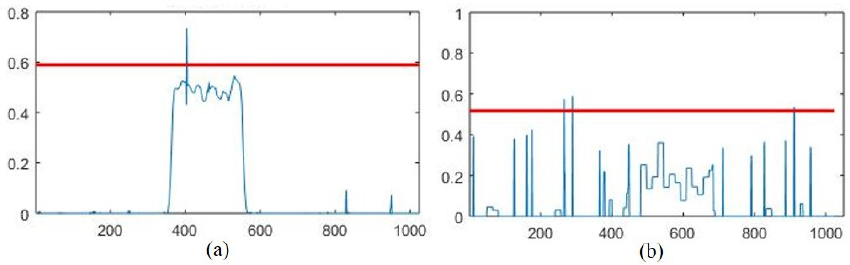
Figure 7. Unsuccessful detection due to: ( a ) high threshold, ( b ) poor fault projection. The red line is the detection threshold at the 95% confidence level.